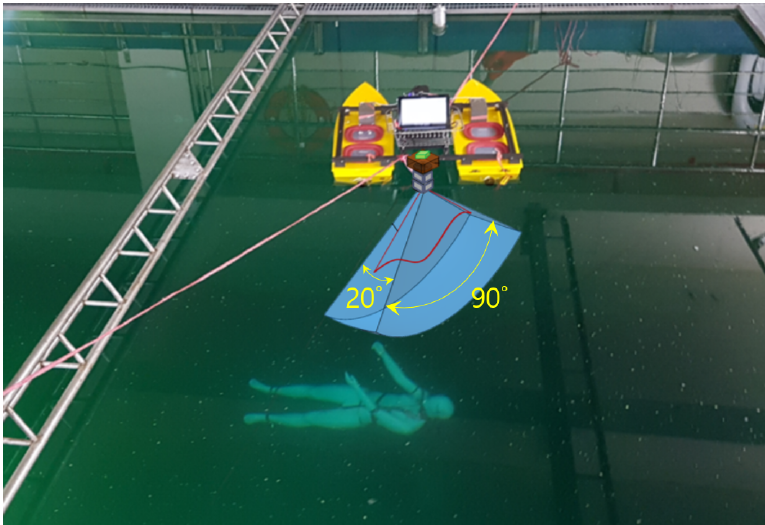
Figure 6. Picture of the experimental setup in the clean water testbed of Korea Institute of Robot and Convergence. BlueView M900-90 has the view field of 90 degrees and the beam width of 20